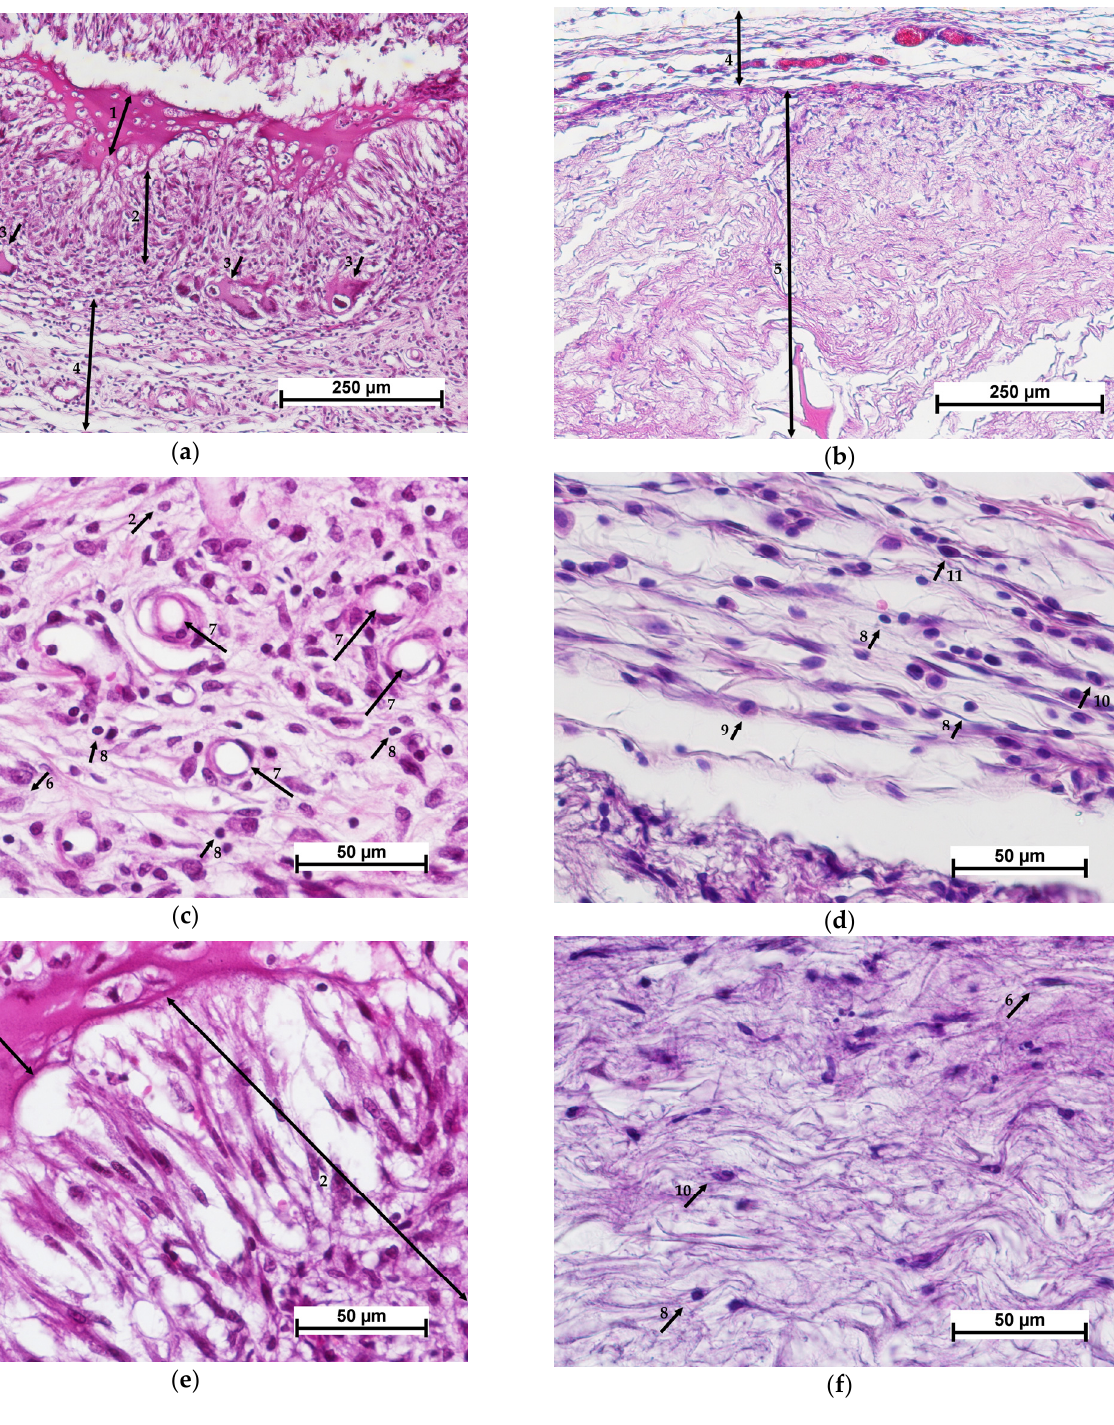
Figure 4. Histological picture—day 7. Comparison of cell-free scaffold ( a , c , e ) and collagen matrix ( b , d , f ). ( a , b )—implant with surrounding tissue, general view, ( c , d )—connective tissue structure surrounding the implant, ( e )—CFSs and resorbing cells, ( f )—collagen matrix structure. Staining with hematoxylin–eosin. Note: (1)—scaffold; (2)—resorbing cell (macrophage); (3)—giant multinucleated cells; (4)—surrounding connective tissue; (5)—collagen matrix; (6)—active fibroblasts; (7)—blood vessels; (8)—lymphocyte; (9)—monocyte; (10)—granulocyte; (11)—mast cell.